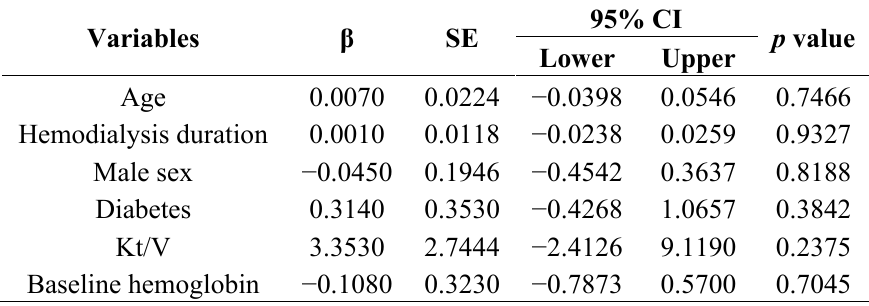
Table 3. Independent predictors of change in erythropoietin responsiveness index in the polaprezinc